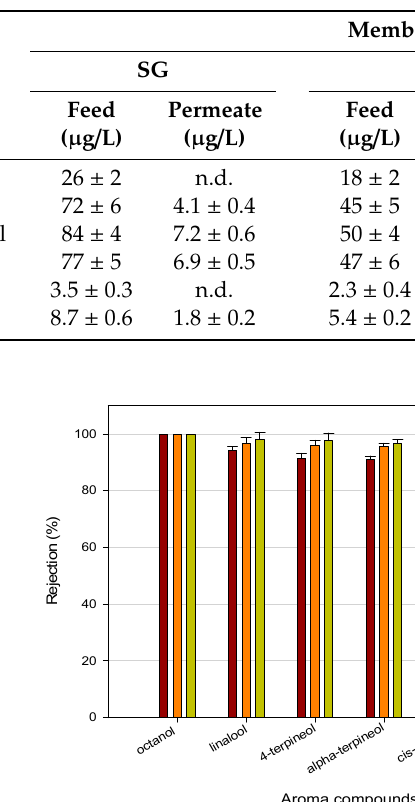
Table 2. Analyses of aromatic compounds in feed and permeate streams of condensed water from thermally evaporated orange juice treated by RO membranes.